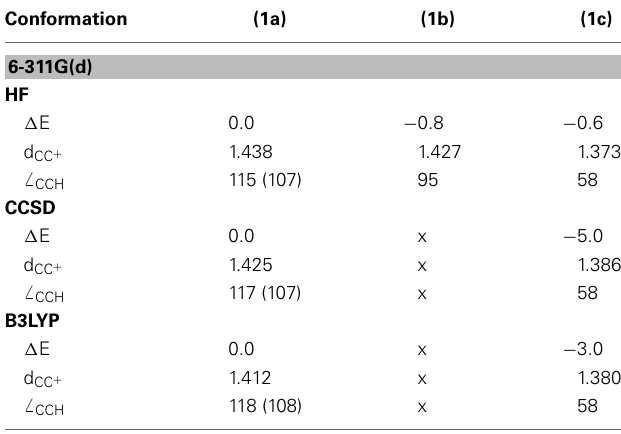
Table 1 | Energetics and key geometrical parameters of the ethyl cation in the conformations of Figure 2 ( (cid:2) E in kcal/mol, d CC + in Å, ◦ ). (cid:2) CCH in